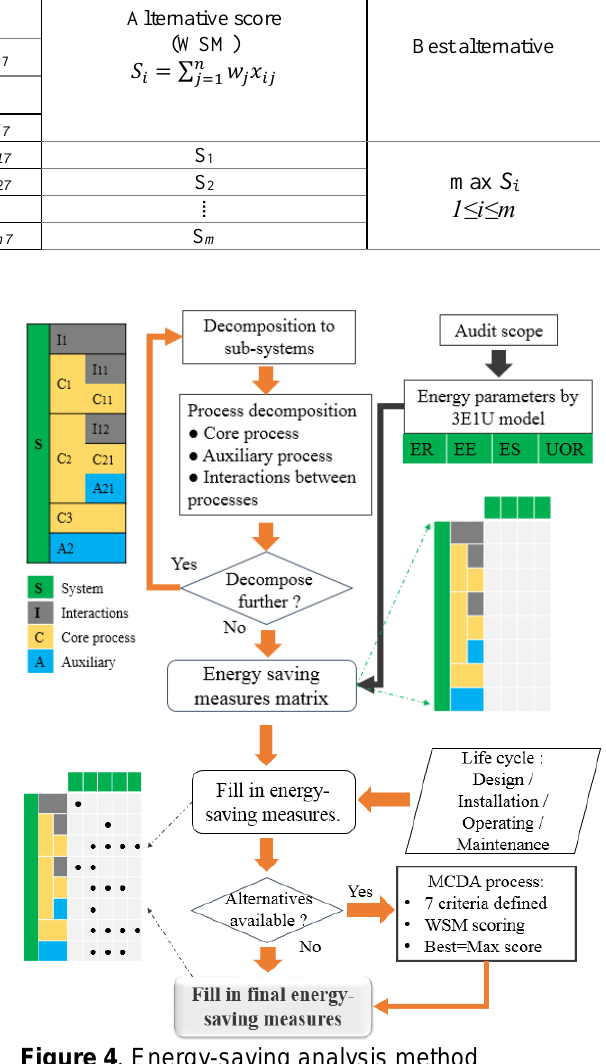
Figure 4 . Energy-saving analysis